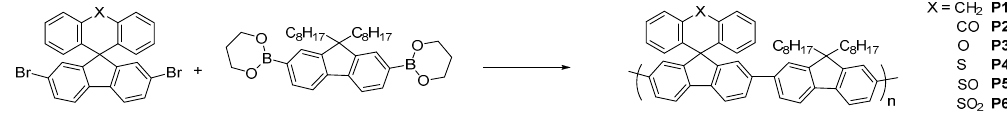
Figure 2. Molecular structure and synthesis of polymers P1 – P6 .